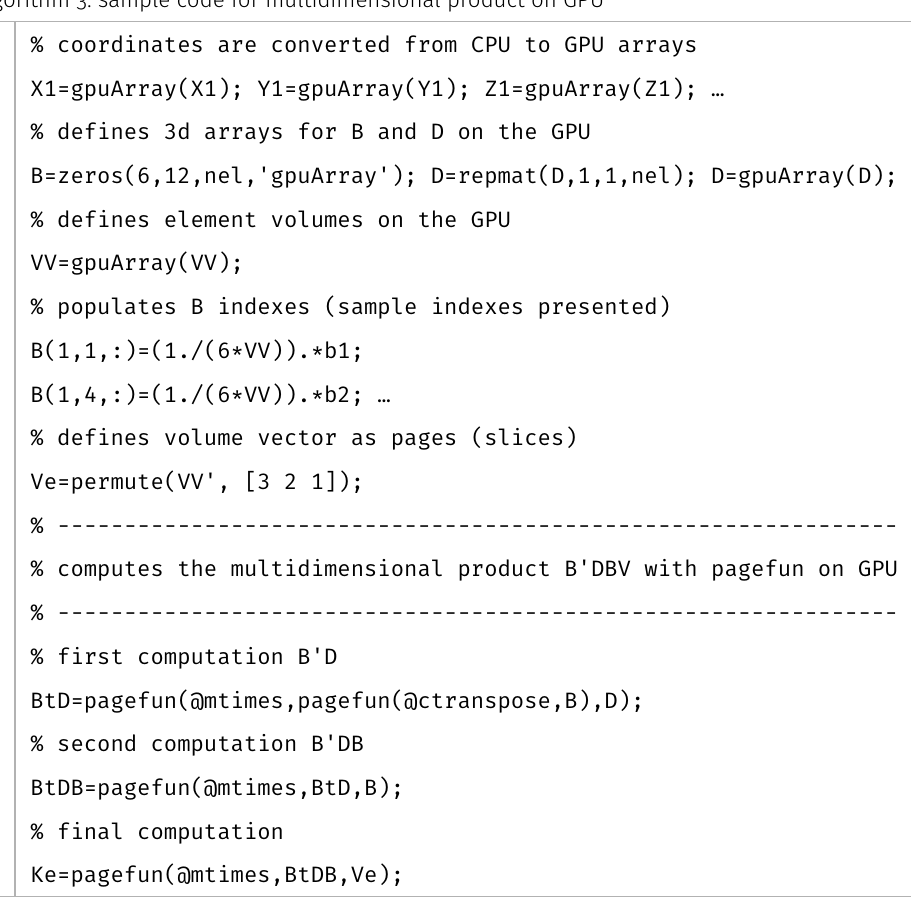
Algorithm 3: sample code for multidimensional product on